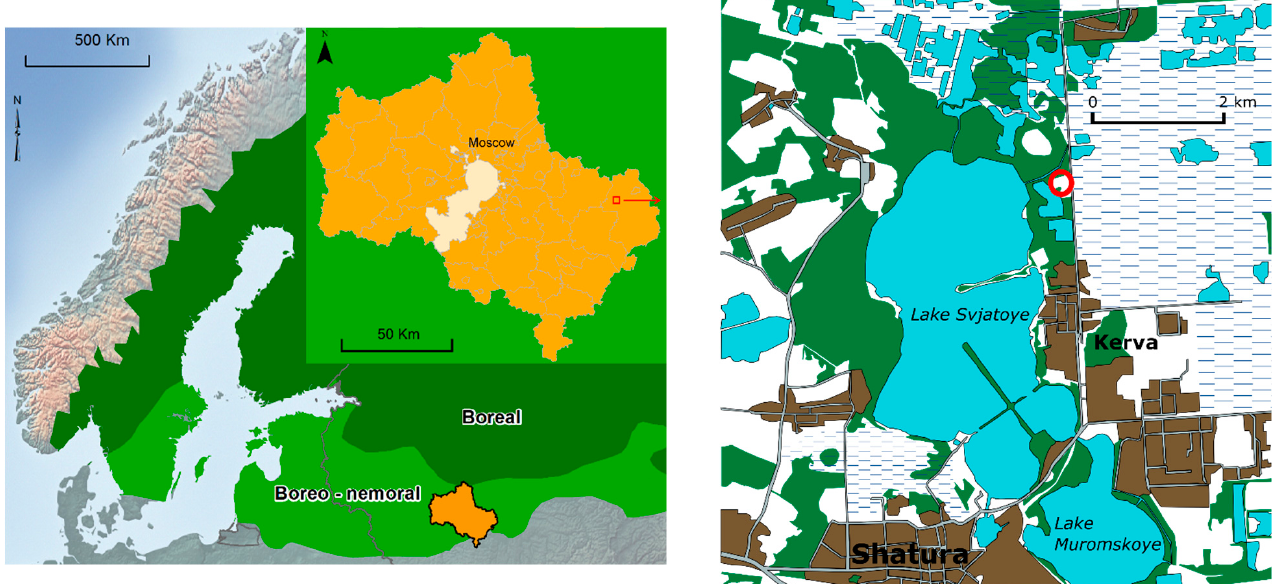
Figure 1. Location of the study area. The red circle in the right figure shows the location of the burned site studied. In the right figure: green, forest; blue, water; brown, urban area (incl. dacha complexes); white, arable land on mineral soil; striped, open peatland.